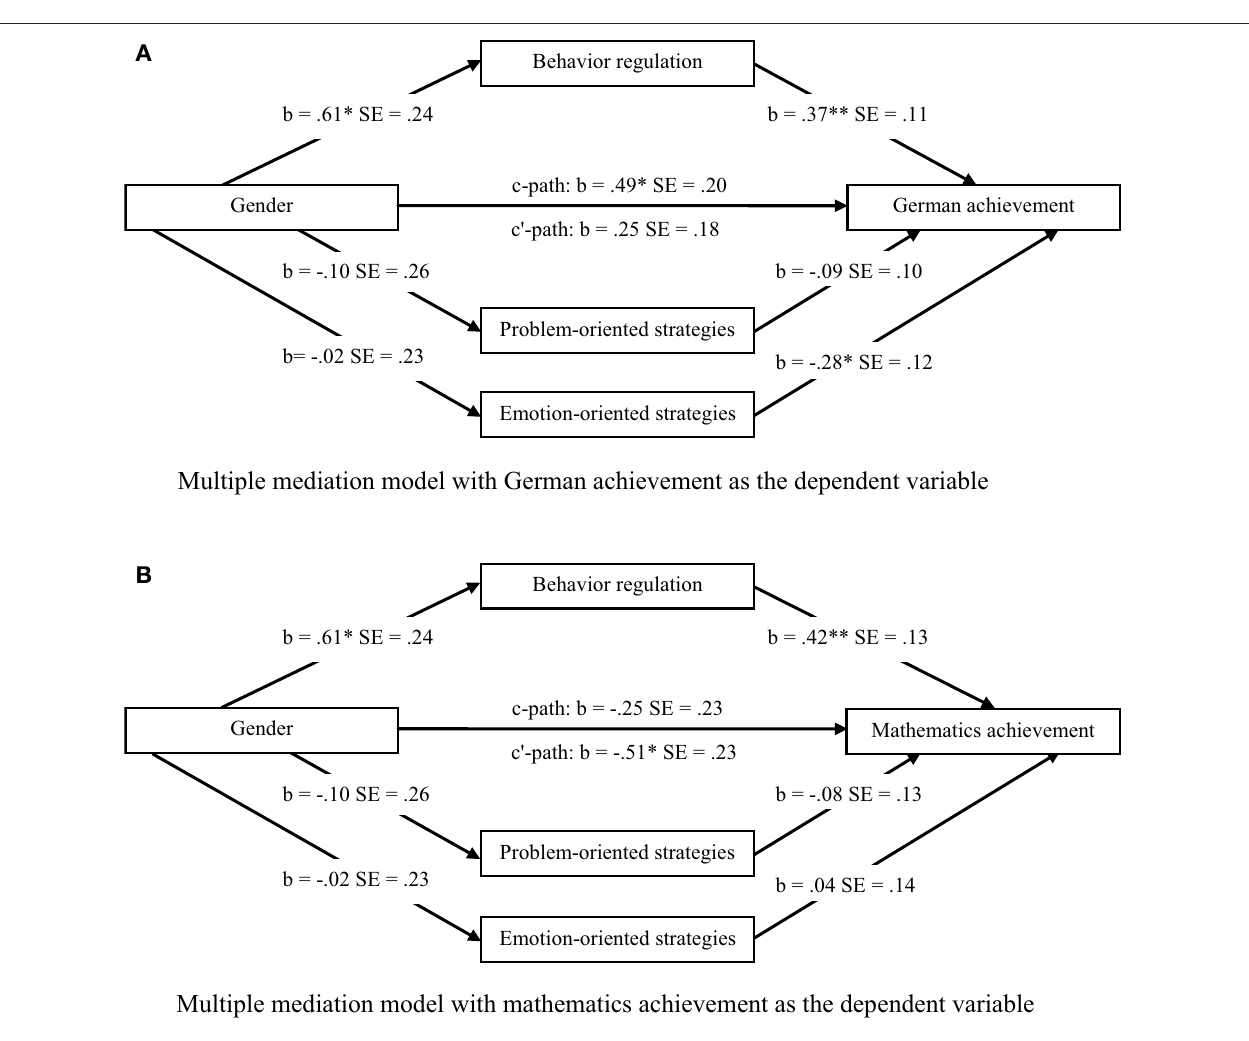
FIGURE 1 | Multiple mediation tests of the relations of gender to German and mathematics achievement mediated by behavior regulation and strategies of emotion regulation. Multiple mediation test of the relation between gender and German achievement mediated by behavior regulation, problem-oriented strategies, and emotion-oriented